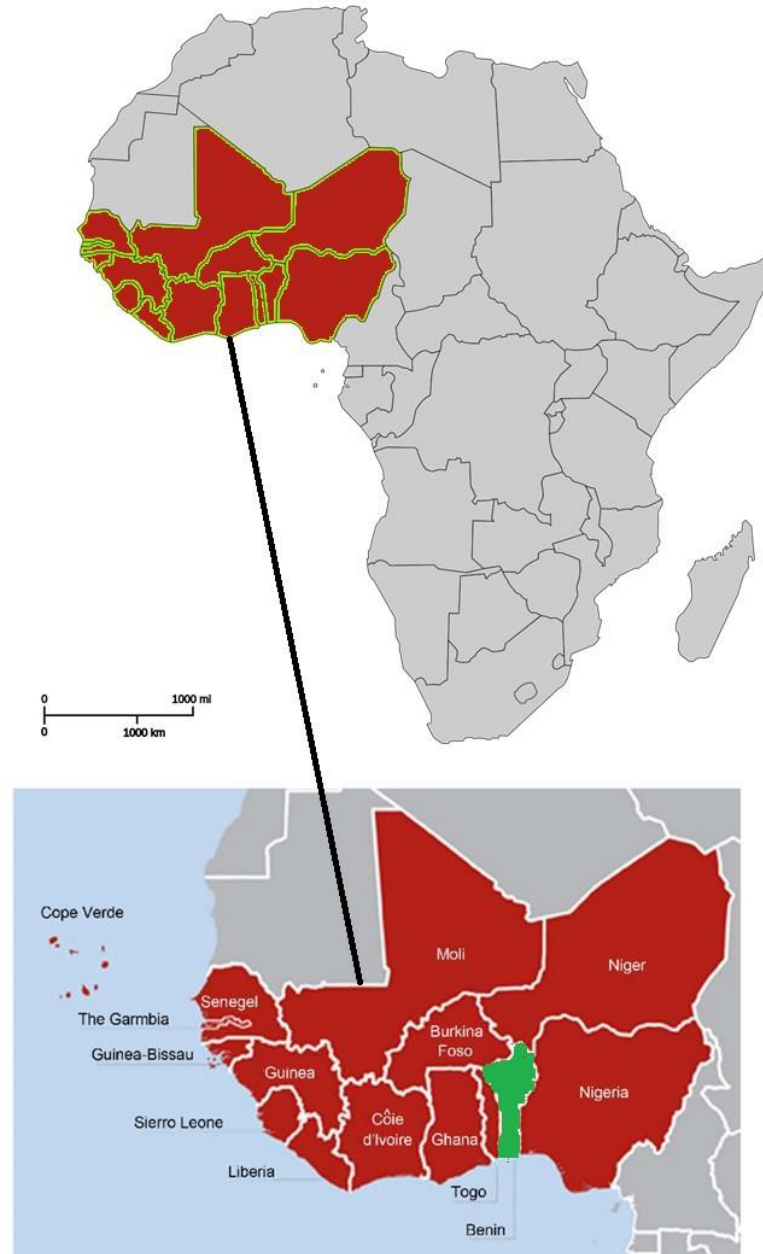
Figure 1. Map showing the geographical location of Benin in West Africa. Source: adapted from [24,25]. Table 1. Plants studied and their authenticated numbers.